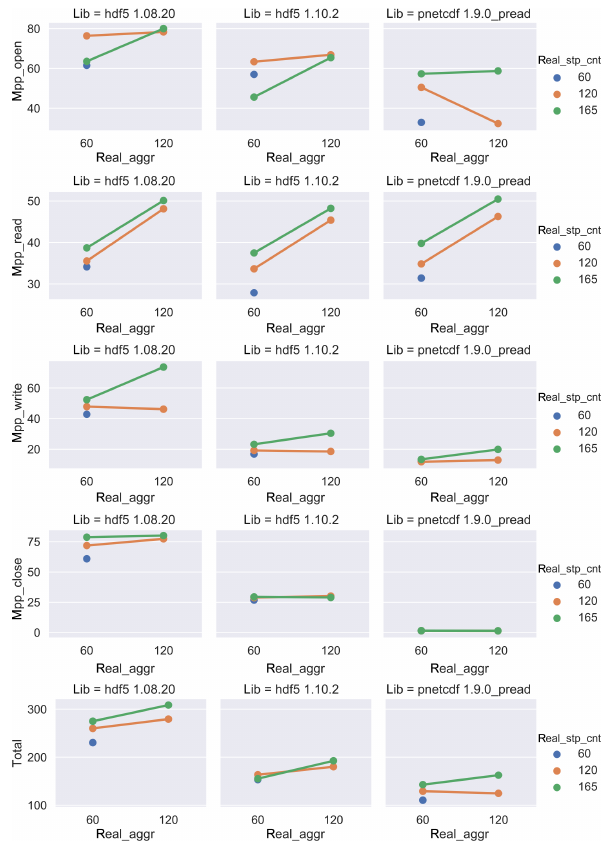
Figure 9. The I / O performance of different library/format bindings with a variety of aggregators and stripe counts by using 960